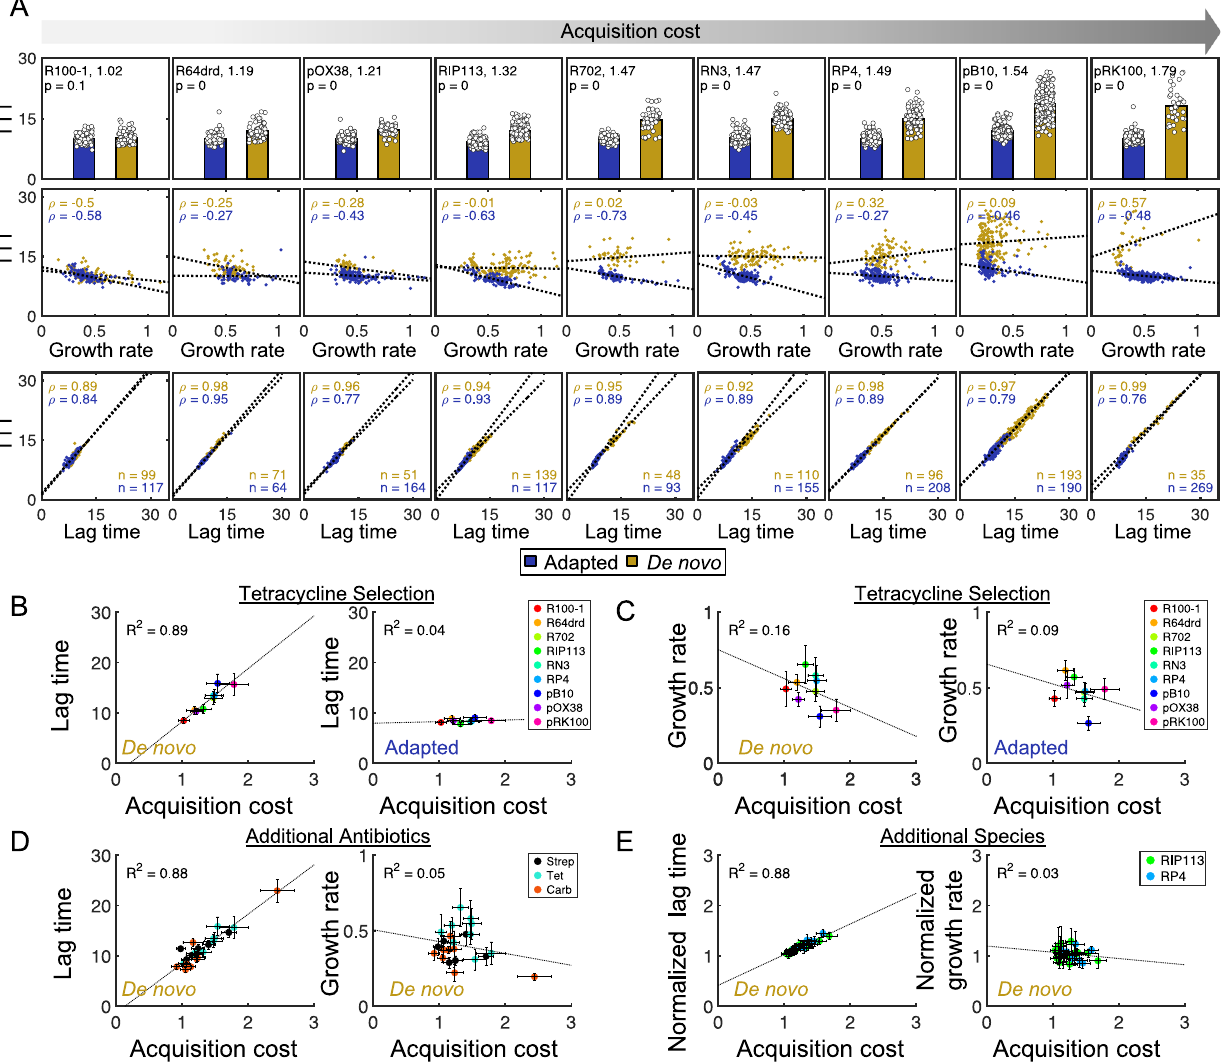
Fig. 2 | Lag time, not growth rate, drives plasmid acquisition cost. A Top: De novo (yellow) and adapted (purple) transconjugants TTT in hours (hr) for nine plasmids under tetracycline/rifampicin selection. The top left values correspond to acquisition cost magnitude (i.e., 1.02 for R100 − 1). Bar height represents the mean TTT of all n colonies. Middle: Growth rate (hr − 1 ) versus TTT. Bottom: Lag time (hr) versus TTT. Markers represent individual colonies. P values in the top left corner for each plasmid are calculated from Bonferroni-corrected two-sided t -tests. The number of colonies ( n ) per population is displayed in the bottom row each panel. Plasmids increase in acquisition cost from left to right (gray arrow). B , C Lagtime(y-axis)( B )orgrowthrate( C )forallnineplasmidsfrom(2 A ) plotted as a function of acquisition cost (x-axis) for both de novo (left) and adapted (right) transconjugants. Individual markers correspond to distinct plas- mids: R100-1 (red), R64drd (orange), R702 (chartreuse) RIP113 (green), RN3 (mint),RP4(blue),pB10(darkblue), pOX38(purple), andpRK100(pink).Datafor A – C are pooled across at least three independent biological replicates, and the resulting total number of colonies ( n ) per population is shown in the bottom row